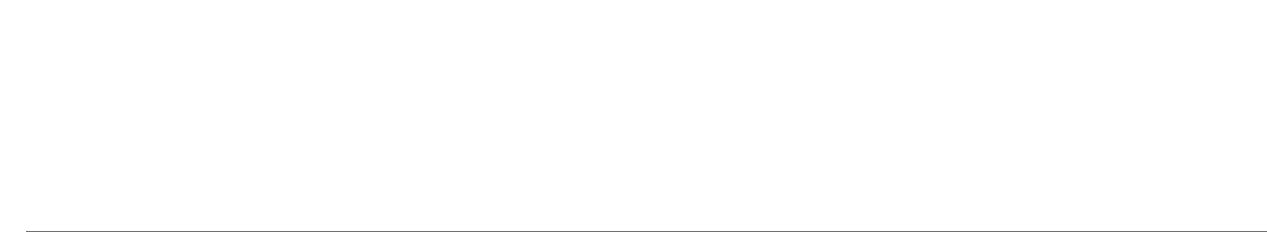
Frontiers in Environmental Science |